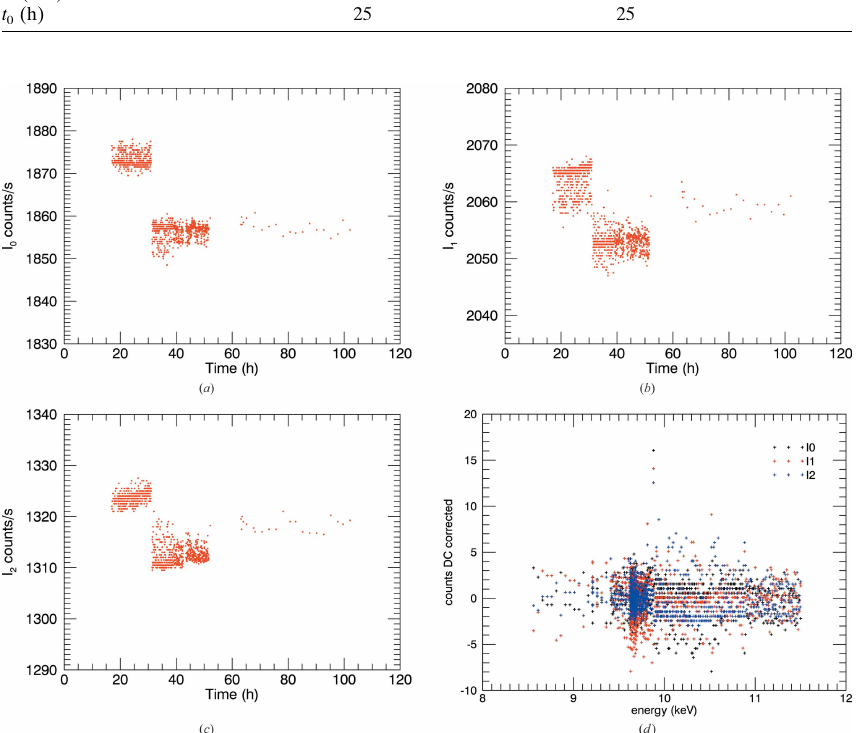
Figure 4 Dark-current measurements of each ion chamber ( a ) I 0 , ( b ) I 1 , ( c ) I 2 . The dark current can then be subtracted. The discontinuity follows a change in detector gain. ( d ) This noise is included in the variance in counts in the uncertainty of the EXAFS spectra.